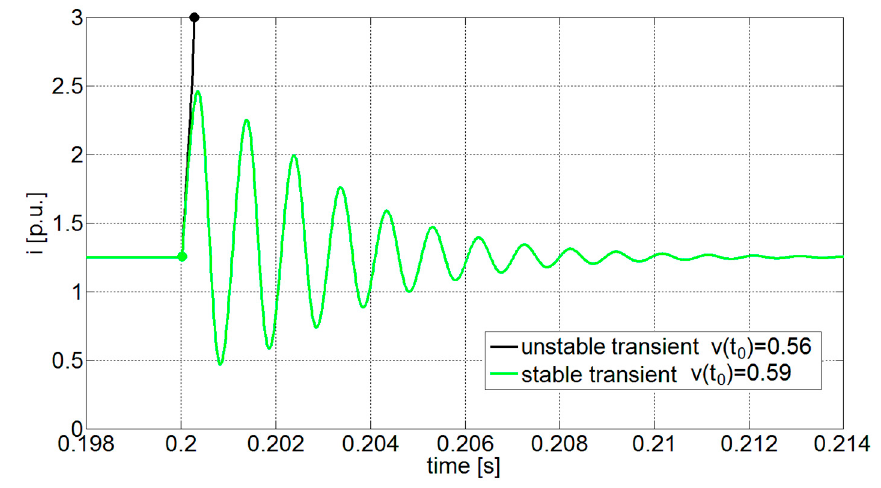
Figure 5. Current transients due to a voltage impulse perturbation at t = 0.2 s.